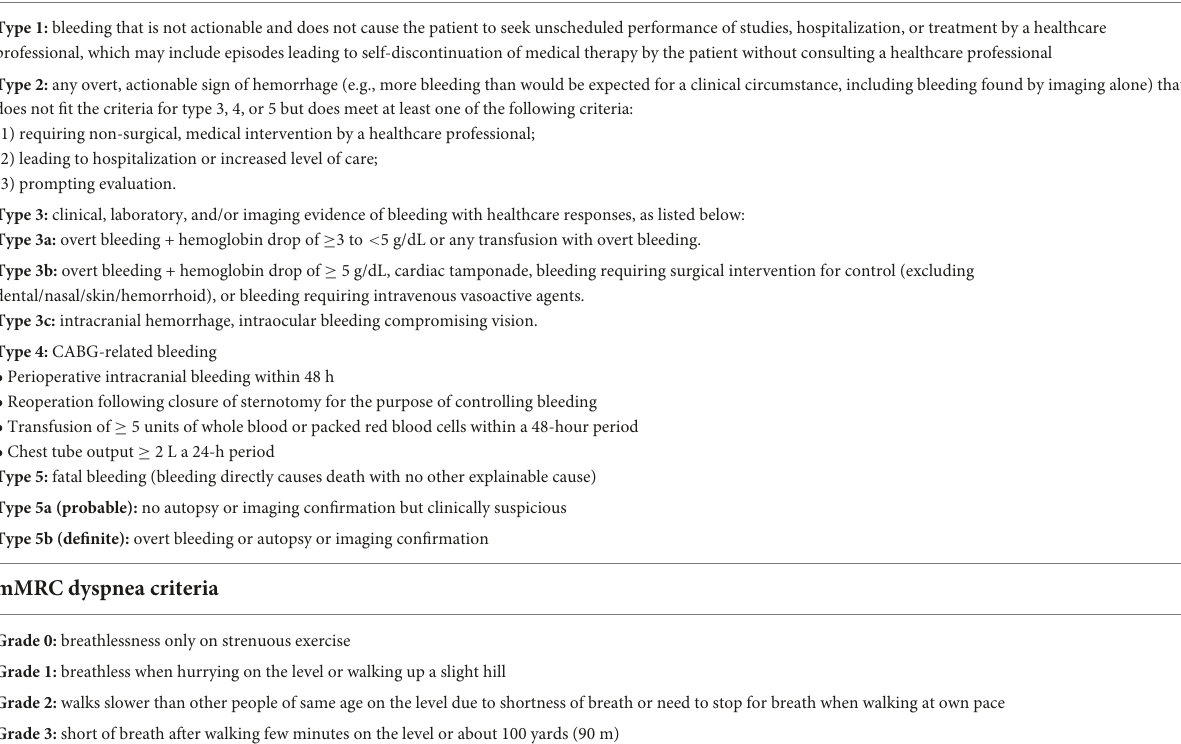
TABLE 1 Definitions of bleeding and dyspnea episodes (17–19). BARC bleeding